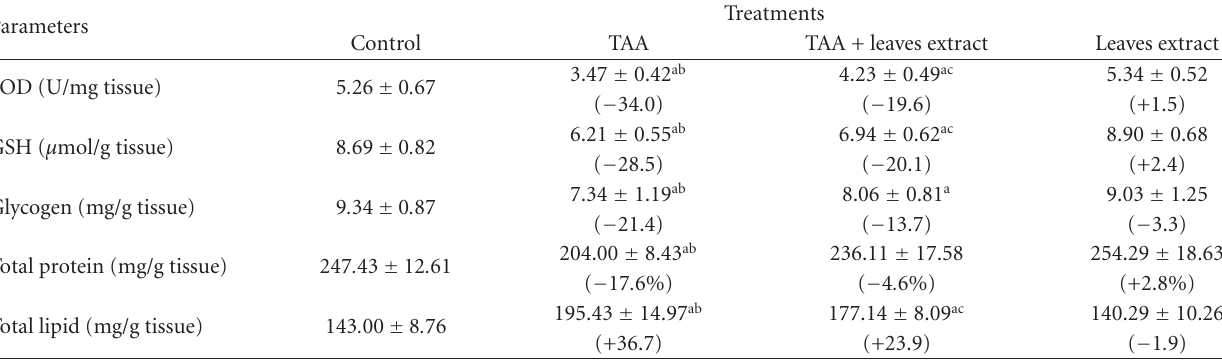
Table 2: Liver SOD, GSH, glycogen, total protein, and total lipid levels of control, TAA, TTA plus G . biloba leaves extract, and G . biloba leaves extract treated mice ( n = 7). Percentage changes are included in